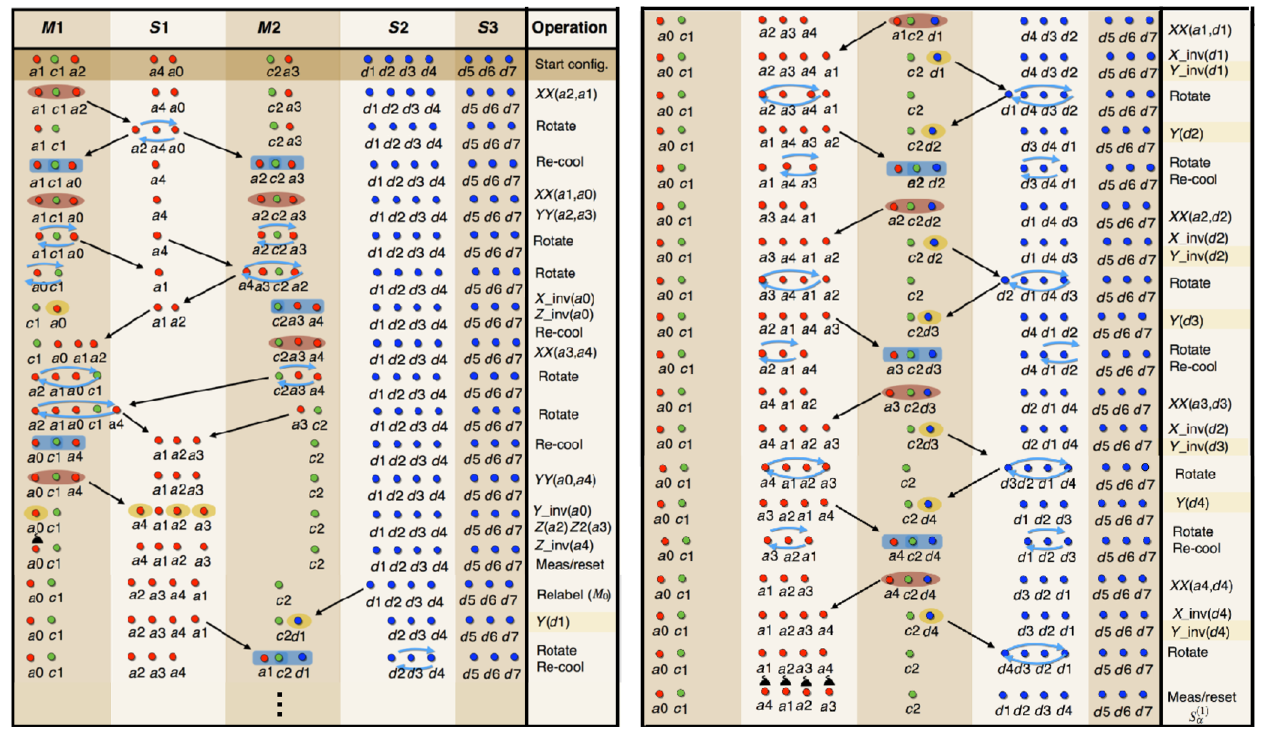
FIG. 21. Real-space representation of the shuttling-based, two-species QEC cycle with a DiVincenzo-Shor scheme: We represent the 1 Þ sequence of operations for the fault-tolerant DiVincenzo-Shor readout of a single stabilizer operator S ð α for α ¼ x or z in two panels, and we use the same conventions as in Figs. 15, 18, and 19. The extra cooling ions c1 , c2 are placed in the manipulation zones M 1 , M 2 , and are again depicted by a green circle. The rightmost columns of both panels contain the sequence of operations that take place. In addition to the ones described in previous figures, we include X - and Y -type MS gates XX ð i; j Þ and YY ð i; j Þ depicted by red ellipses, as π = 2 Þ (7), and analogously for Y ð j Þ ; Y inv ð j Þ , and Z ð j Þ ; Z inv ð j Þ , all well as single-qubit rotations X ð j Þ , X inv ð j Þ corresponding to X j ð(cid:3) π Þ . Finally, some Y ð j Þ ; Y inv ð j Þ rotations of which are depicted by yellow ellipses. We also introduce Z 2 ð j Þ , which corresponds to Z j ð on the rightmost columns of each panel are shown inside a yellow rectangle, which implies that they are only applied for a Z -type stabilizer readout ( α ¼ z ). We have also included a classical relabeling operation, Relabel, conditional on the measurement outcome M z 0